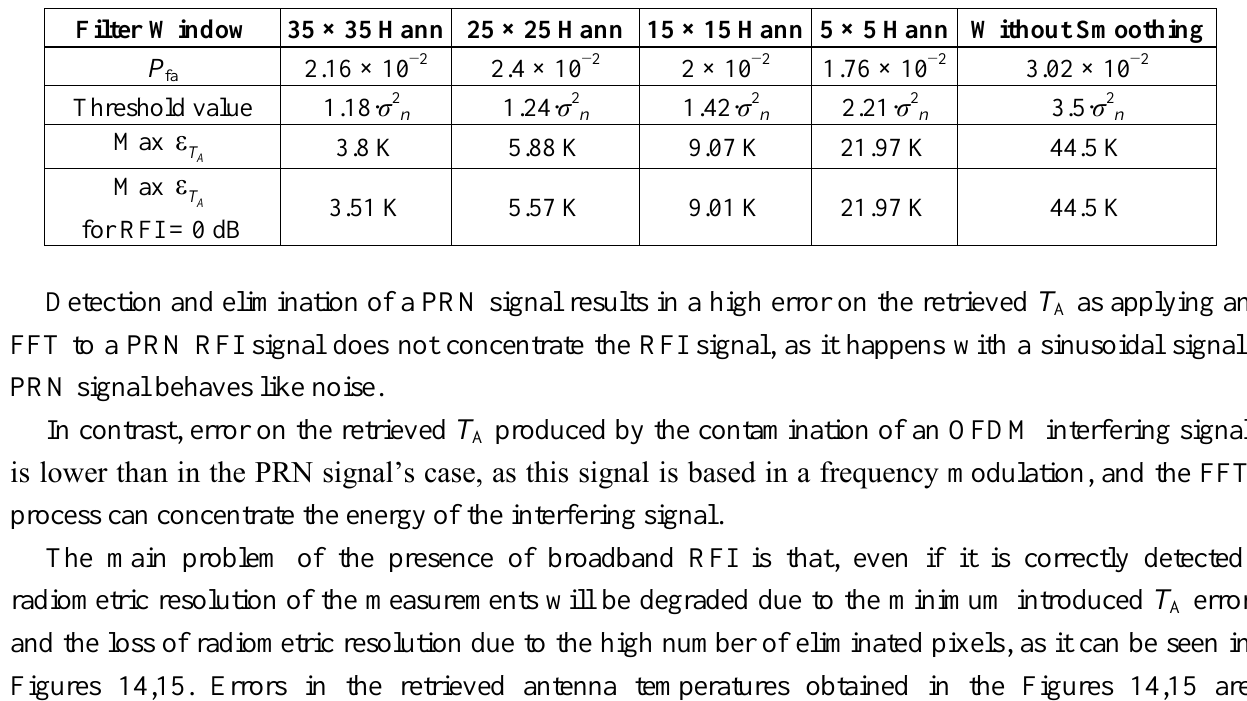
error for the best threshold P for four different cases of A fa error in absence of RFI for the most A